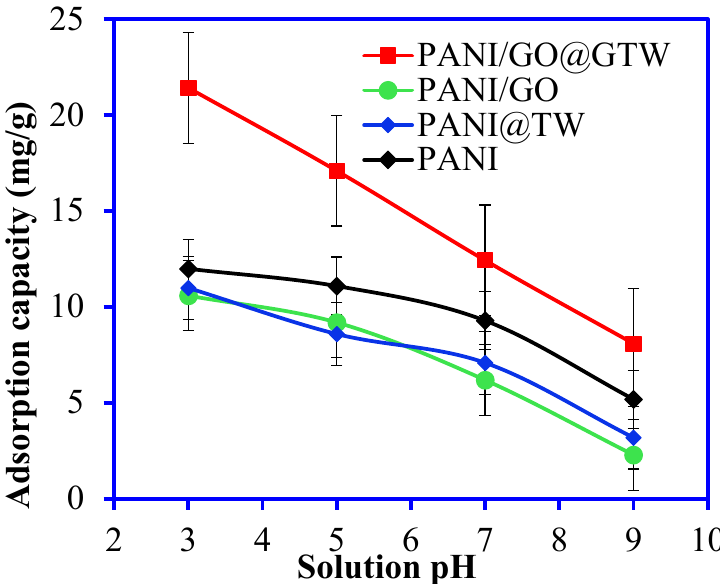
Figure 6. Adsorption of the Br − ions from aqueous solution at various solution pHs (Br − conc.: 50 mg/L, time: 150 min, solution volume: 20 mL, adsorbent mass: 0.05 g).